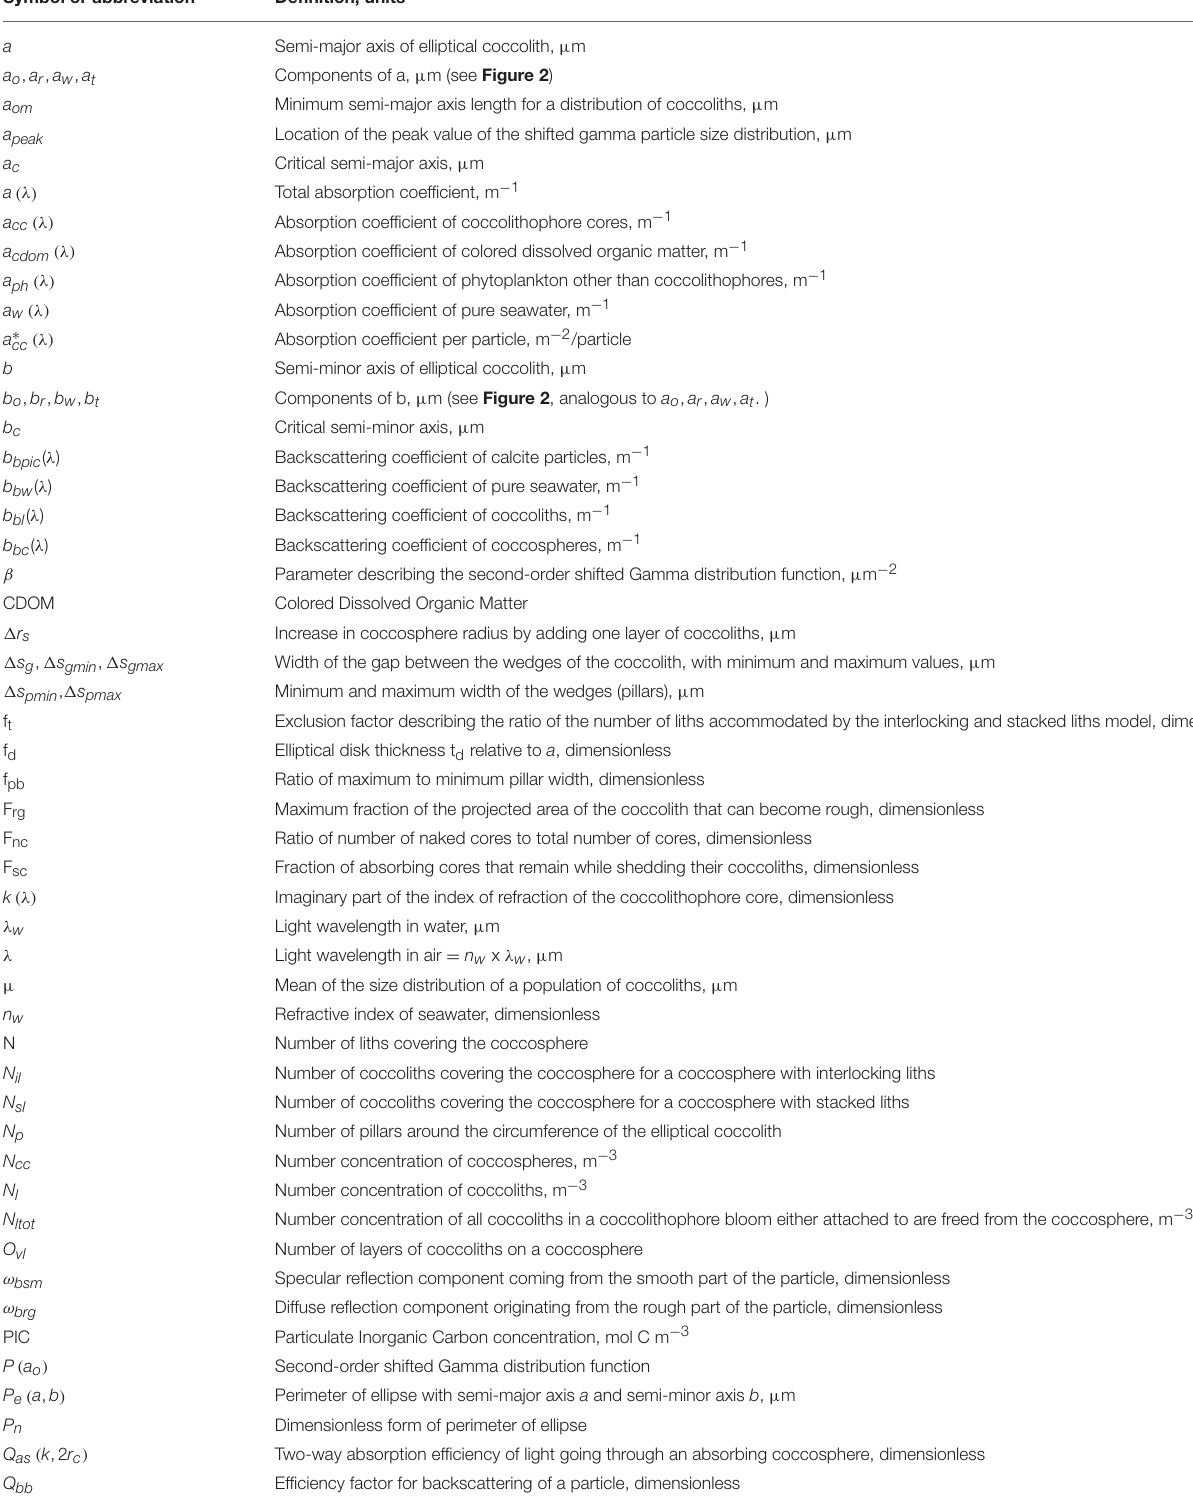
TABLE 1 | List of abbreviations, symbols, definitions, and units. Symbol or